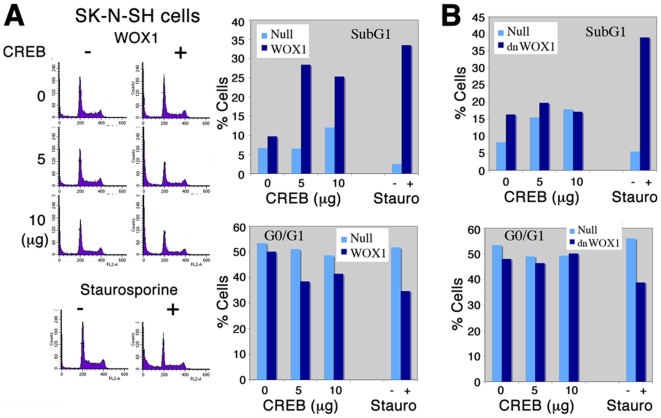
CREB enhances the apoptotic function of WOX1.(A) SK-N-SH neuroblastoma cells were transfected with a
non-apoptotic dose of WOX1, in the presence of various amounts of CREB
by electroporation. These cells were cultured for 48 hr. Cell cycle
analysis by flow cytometry showed that CREB enhanced the apoptotic
function of WOX1 (see the increased cell population at the SubG1 but
reduced population at G0/G1 phases). CREB alone had no effect on
apoptosis. (B) Under similar conditions, when cells were
transfected with CREB and a dominant negative WOX1 (dn-WOX1), little or
no apoptosis occurred. dn-WOX1 blocks WOX1 phosphorylation at Tyr33
[13]. As a positive control of apoptosis,
staurosporine (stauro) was used.